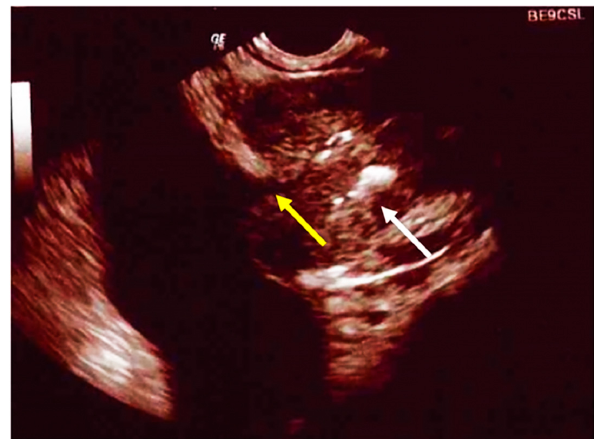
Figure 2. A transrectal ultrasound examination demonstrating calcification within the ejaculatory duct ( white arrow ) with dilatation of the vas deferens proximally ( yellow arrow ). Among the various causes related to infertility are a possible obstructive blockage of the seminal ducts due to the extreme viscosity of the semen [114] and the incorrect dif- ferentiation of Wolf’s ducts secondary to the CFTR mutation [115].